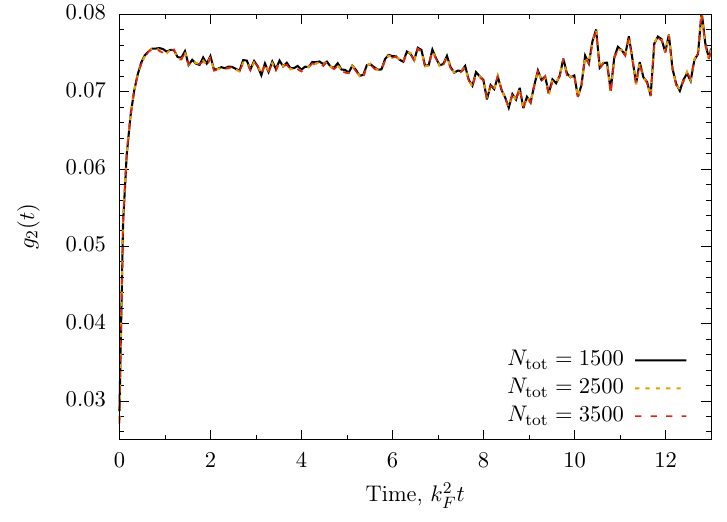
= (cid:0) Ψ † ( 0 ) (cid:1) 2 ( Ψ ( 0 )) 2 follow- 2 = π ( N − 1 ) / R is the F ( t ) for small 2